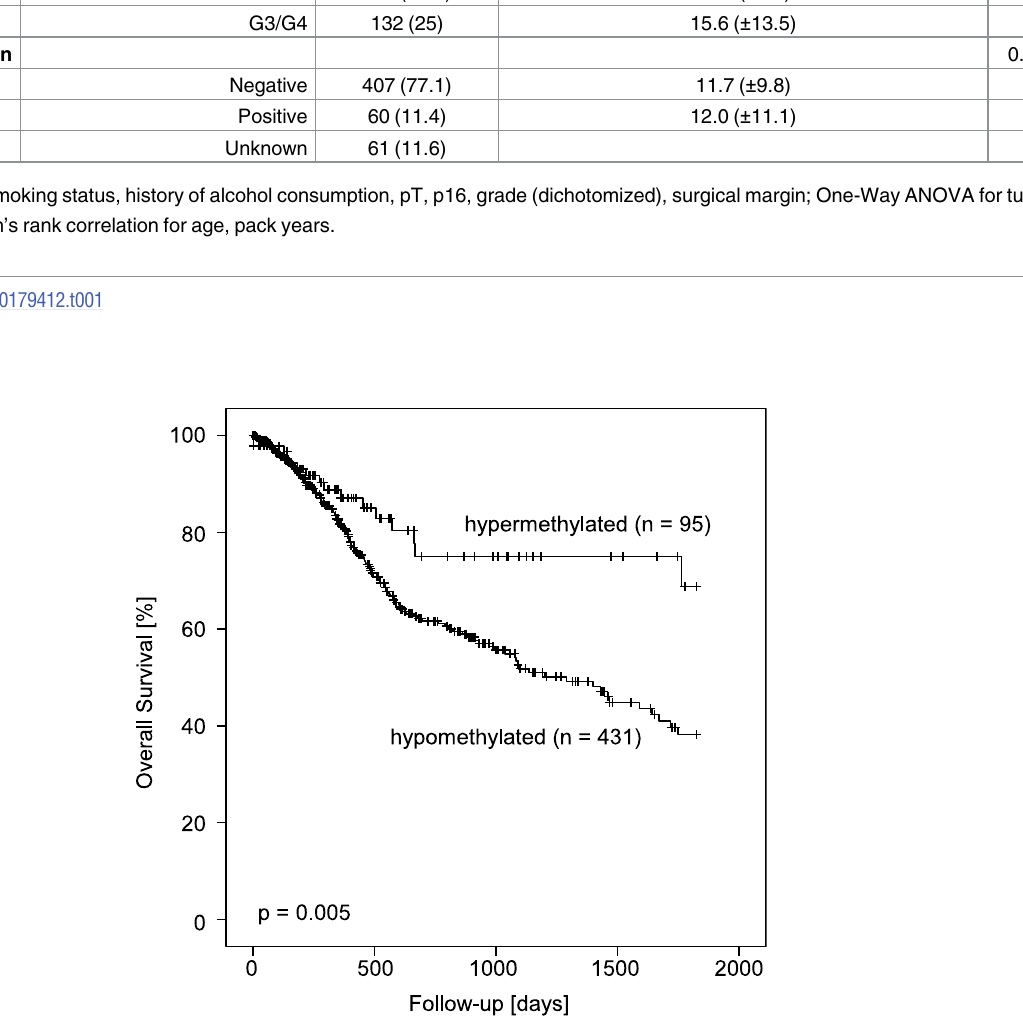
Fig 2. Kaplan-Meier survival analysis. Kaplan-Meier survival analysisof overall survival in 528 HNSCC patients stratified accordingto PITX2 DNA methylationstatus. Overall survival in patients with PITX2 hypermethylated HNSCC was significantly improvedcomparedto patients with PITX2 hypomethylated